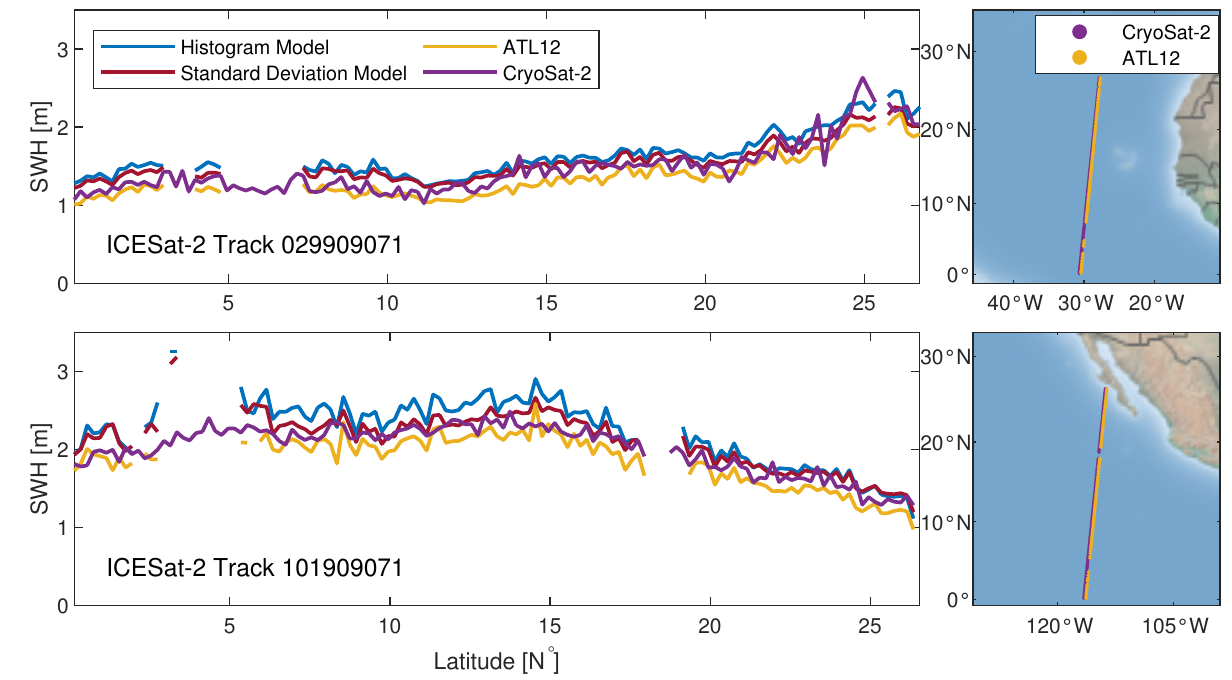
Figure 5. Ground tracks of ICESat-2 orbit segments and the corresponding SWHs for the different models. This plot shows track pass 299 cycle 7 granule 7 ( top ) in the Atlantic Ocean, which has visible gaps for ICESat-2 (due to clouds), and pass 1019 cycle 9 granule 7 ( bottom ) in the Pacific Ocean, which has gaps for both